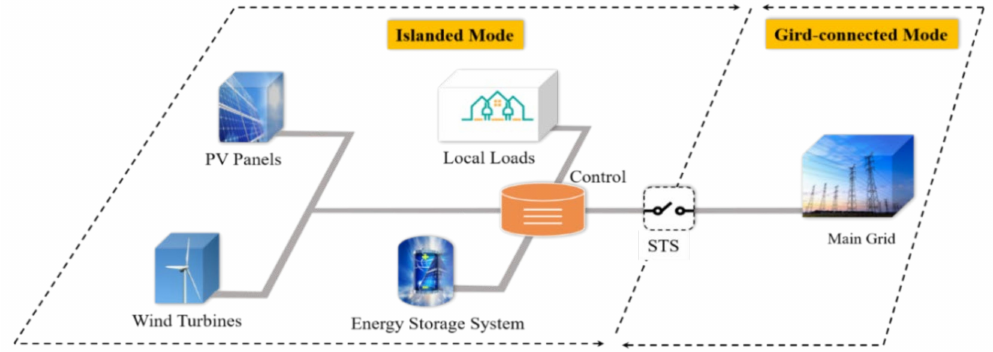
Figure 1. Fundamental microgrid configuration with variable operation